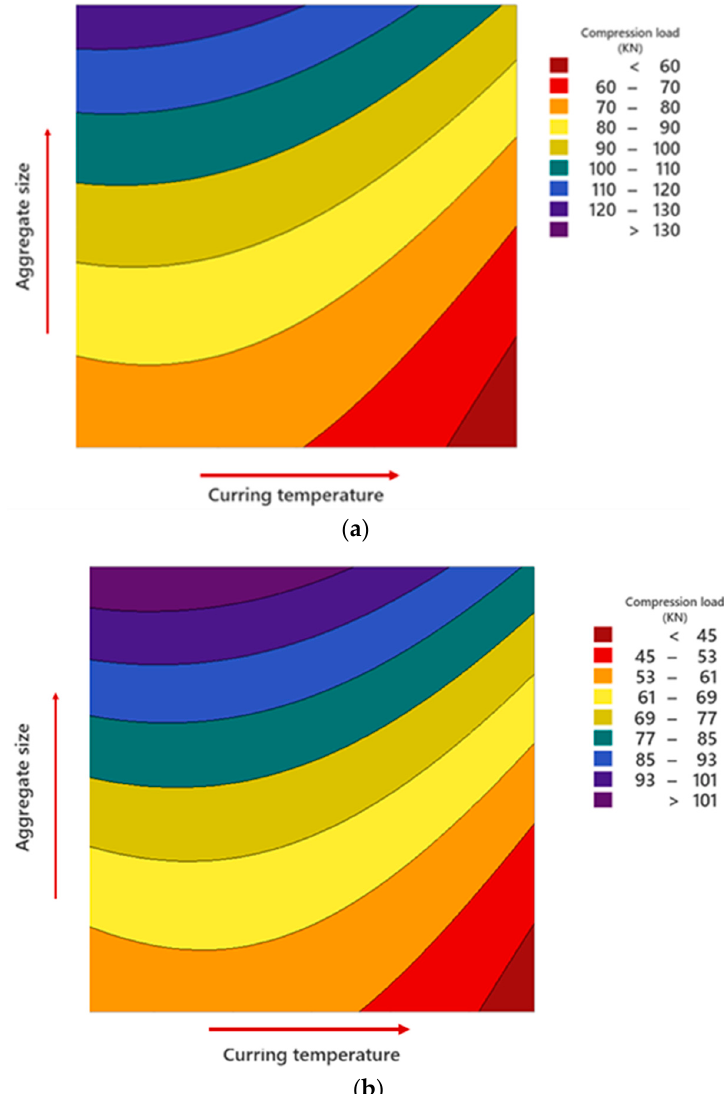
Figure 8. Contour plot of compression load vs. simulations effects of aggregate size and curing tem- perature as a result of response surface analysis for different specimen batches, including ( a ) concrete